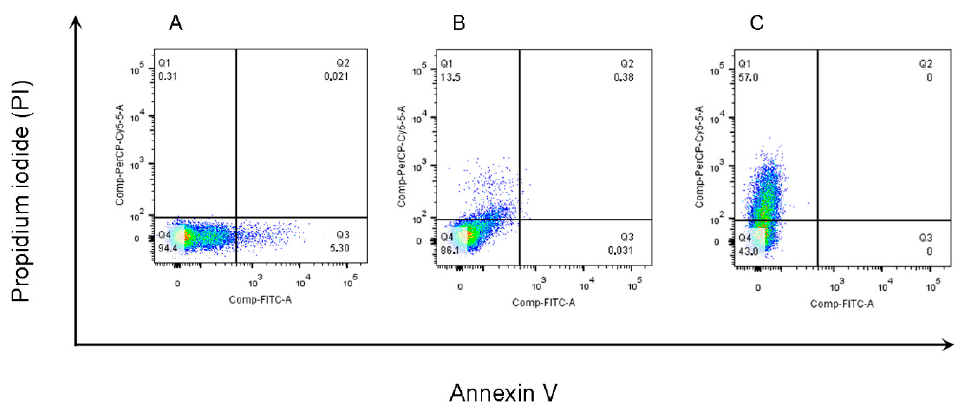
Figure 4. Detection of parasite membrane changes by concurrent staining with annexin V-FITC and PI. Untreated promastigote forms of L. amazonensis ( A ) and treated forms after 24 h with the L1 IC 50 concentration, 1.24 µM ( B ) and 124 µM ( C ), and subsequently stained with annexin V-FITC conjugate and Pin and measured by flow cytometry. Live promastigote forms (Q4) are both annexin V and PI negative. Primary necrotic parasites (Q1) were only stained with PI.